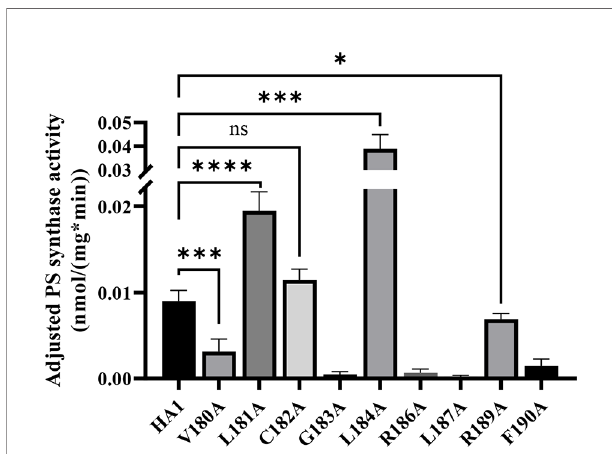
FIGURE 7 | Enzyme activity decreases in some putative serine binding site mutants. Total membranes were collected from cho1 DD , HA1 and each of the putative serine binding site mutants and tested in an in vitro PS synthase assay. Adjusted PS synthase activity was measured from each total membrane. Statistics were calculated using one-way ANOVA, and all mutants were compared to HA1 (*p < 0.05; ***p < 0.001; ****p < 0.0001; ns, not signi fi cant). Each adjusted PS synthase activity was measured in duplicate with a total of six biological